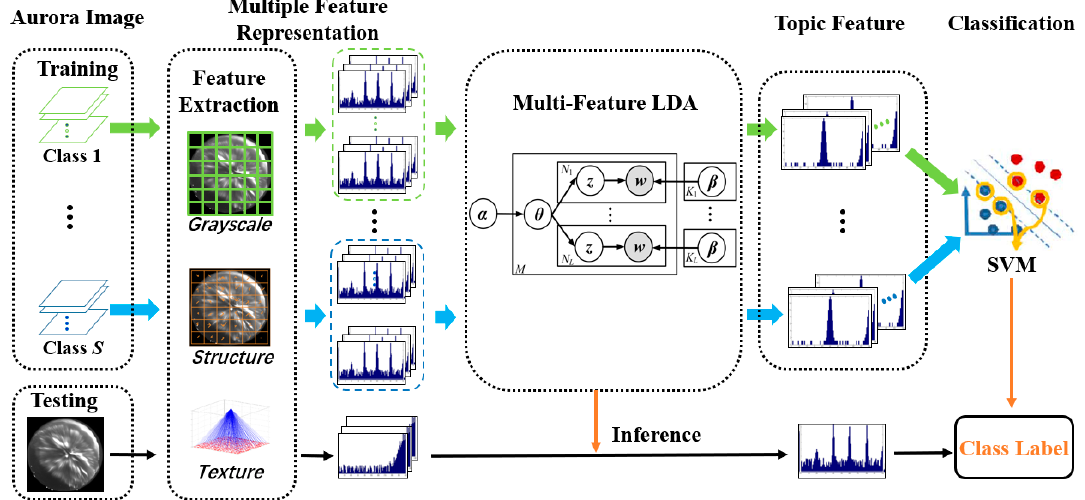
Figure 4. Procedure of aurora image classification based on aurora image classification method based on multi-feature latent Dirichlet allocation (AI-MFLDA).